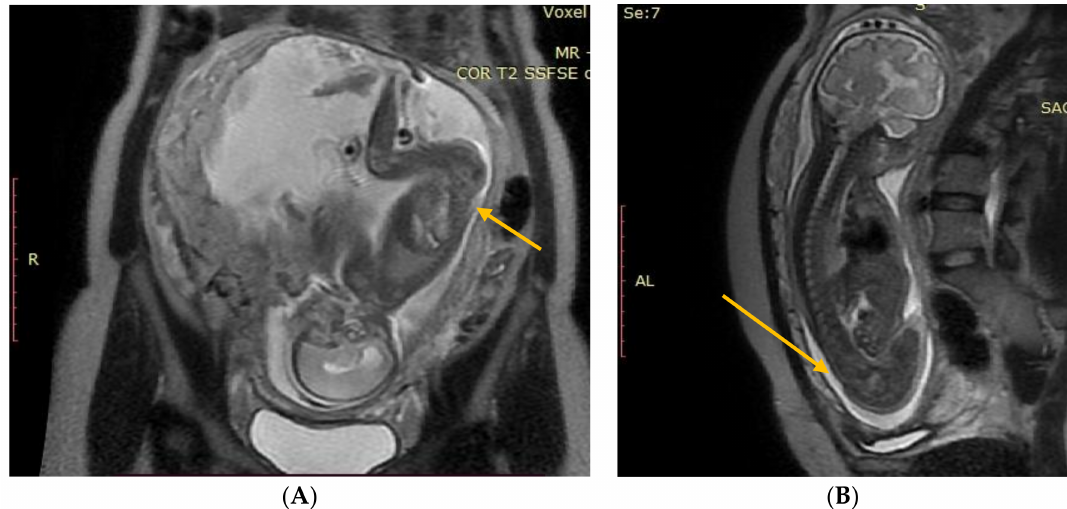
Figure 1. ( A ) Fetal NMR at 21 weeks of gestation. The arrow indicates the myeloschisis, with the area of contact between the split and the uterine wall. ( B ) Fetal NMR at 26 weeks of gestation (4 weeks after intrauterine myeloschisis repair); the arrow indicates the site after a three-layer reconstruction of spina bifida aperta.